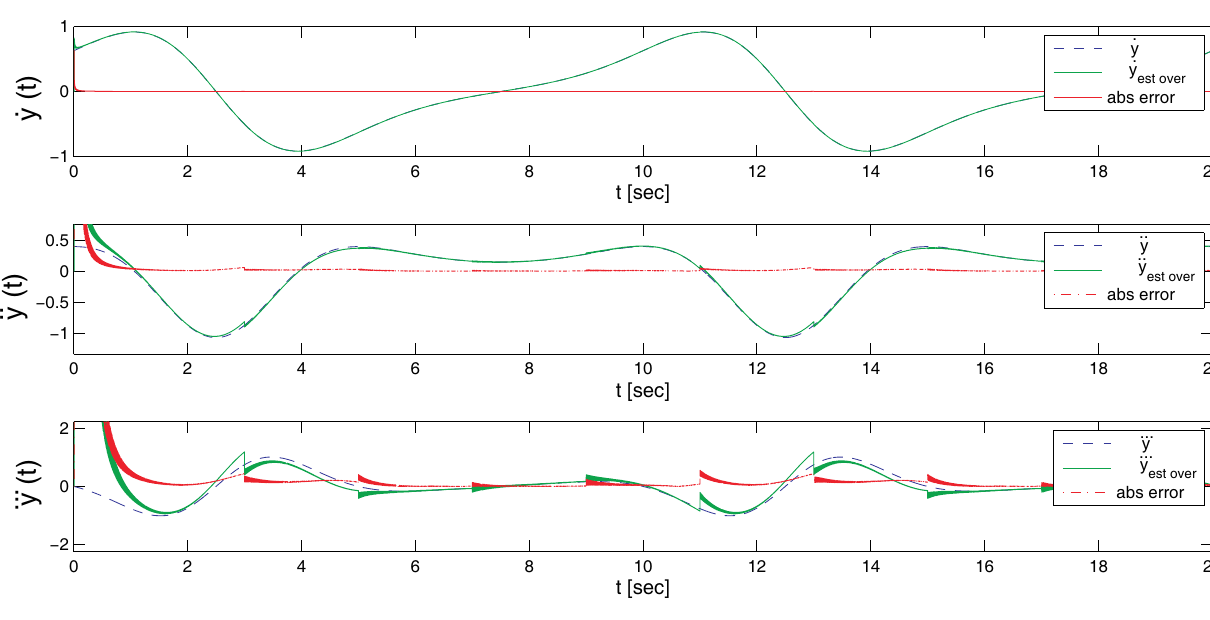
Table 1 includes the results for three different cases: the first two using the same time step, but with a different reset time (four and two seconds, respectively), and a third one using a time step of 1 ms. The lower time resolution in the last case improves the simulation speed by one order of magnitude, at the expense of the quality of the